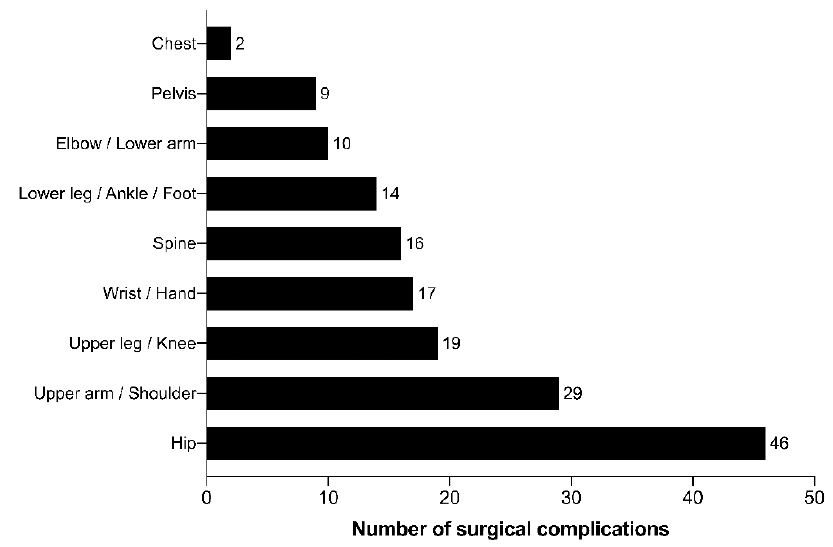
Figure 2. Distribution of the surgical complications among the different body areas.